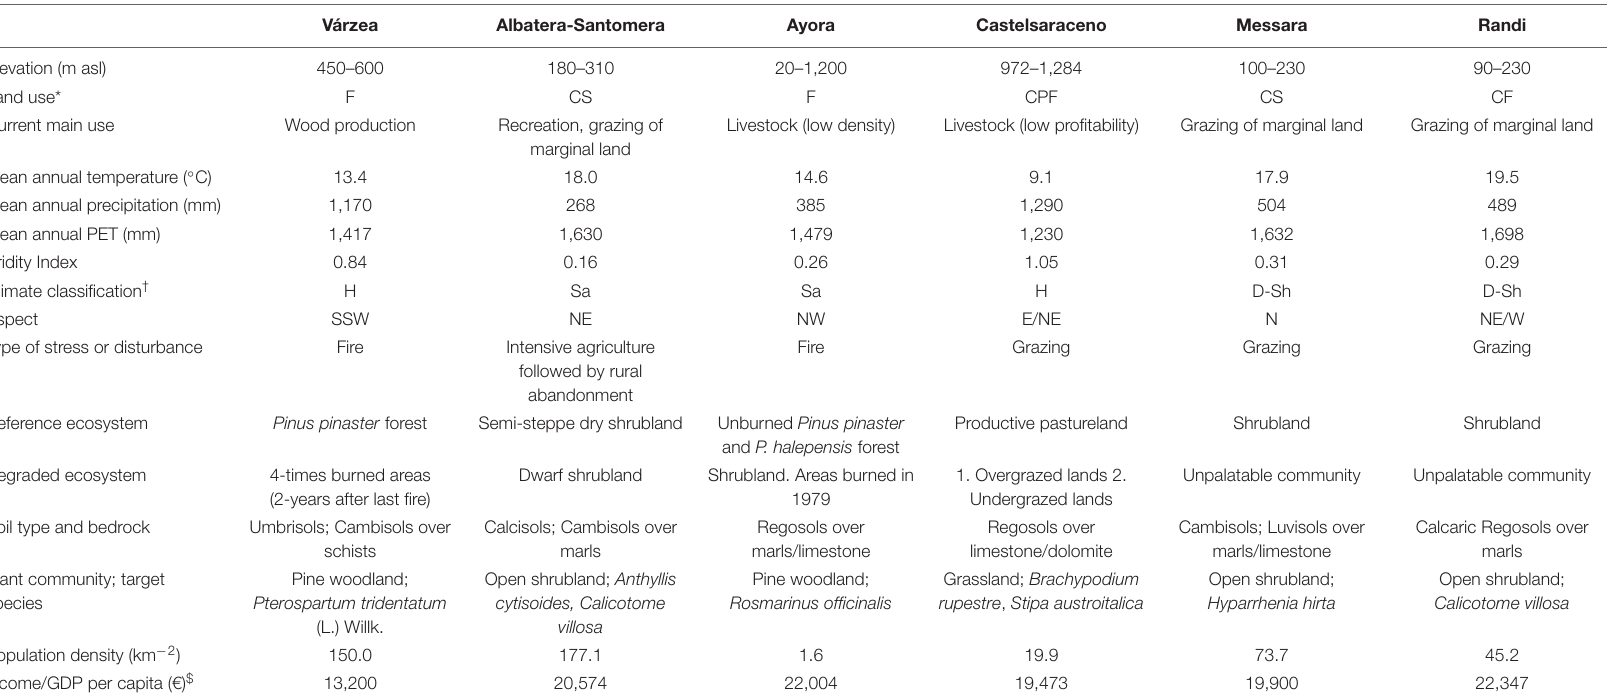
TABLE 1 | Key characteristics of the study sites (adapted from Daliakopoulos and Tsanis,